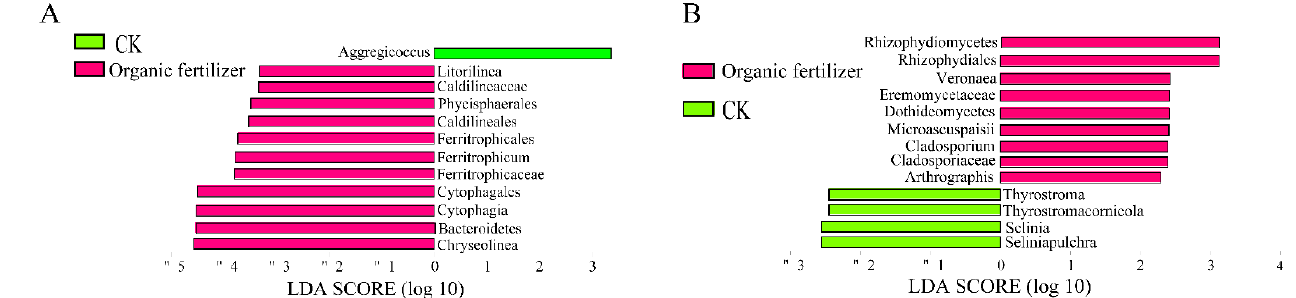
Figure 5. Distribution of LDA values for divergent taxa in bacteria ( A ) and fungi ( B ), with colors representing the corresponding treatments and the length of the bars representing the magnitude of the contribution of the divergent taxa (i.e., the LDA score), showing taxa with significant differences in abundance between groups under conditions where the LDA score was greater than the set value of 3, i.e., biomarkers with significantly higher abundance within each group than in all other groups. Green represents CK; red represents organic fertilizer treatments.